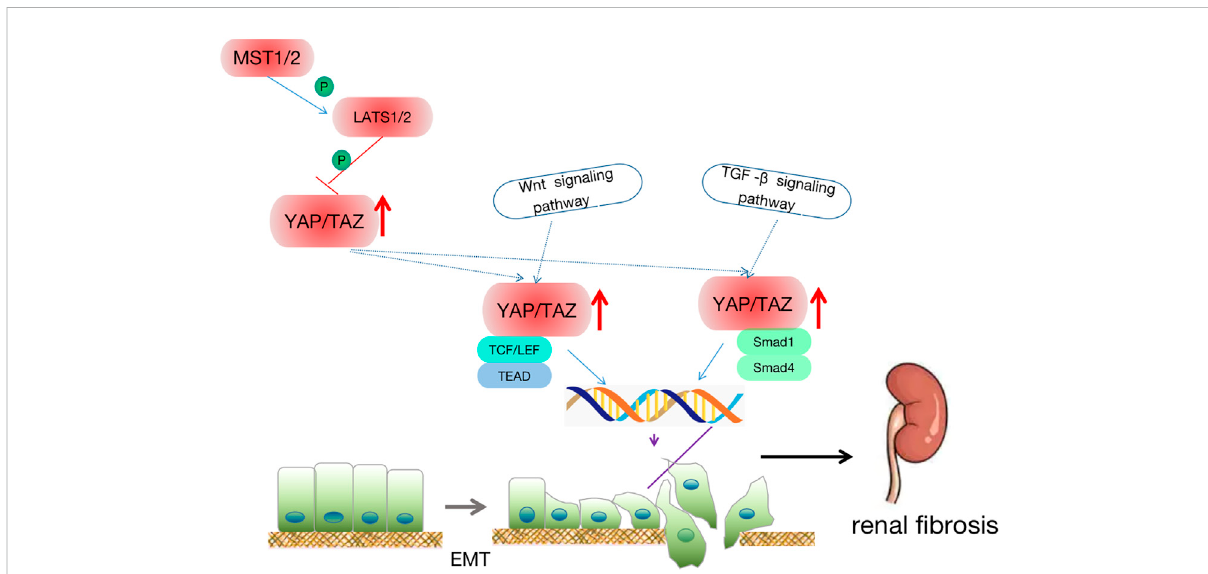
FIGURE 5 Crosstalk between renal fi brosis and the Hippo signaling pathway. Downstream effector YAP enters the nucleus and binds to TEAD, Smad1/ Smad4 to promote epithelial-mesenchymal transition. At the same time, the hippo signaling pathway, TGF, Wnt, and other signaling pathways interact together to participate in cell apoptosis, regeneration, and EMT, thus leading to renal fi